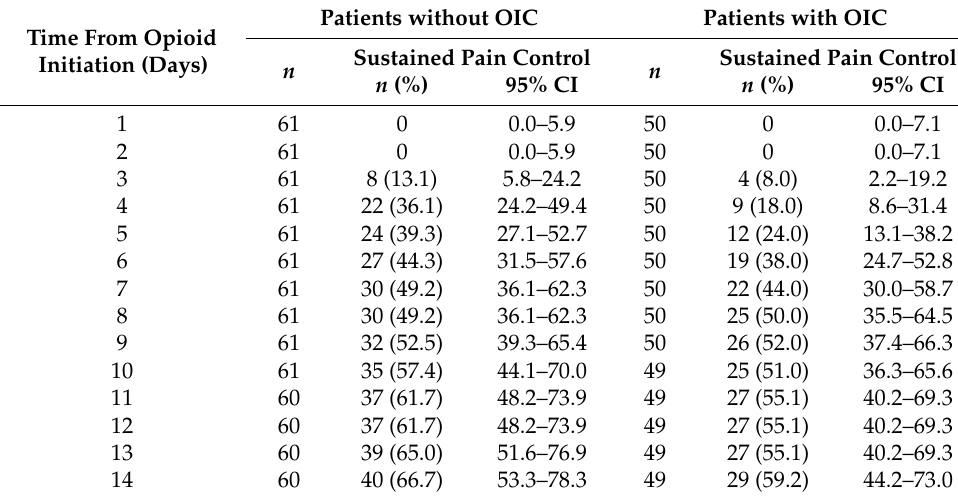
Table 3. Days to Sustained Pain Control in Patients Receiving Opioid Analgesics for Cancer Pain (FAS 2 Inpatient Population).